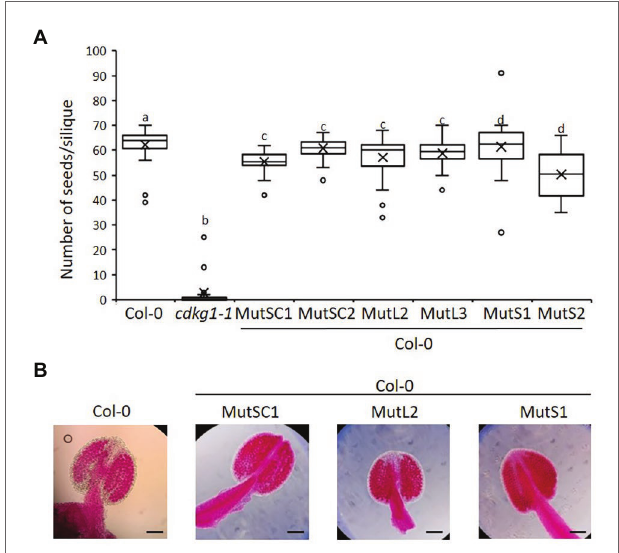
FIGURE 7 | The mutated kinase forms of CDKG1 do not act was dominant negative kinases in a Col-0 background. (A) Fertility counts of the kinase mutant transformed plants. The average number of seeds per silique was determined for Col-0, cdkg1-1 , and lines expressing the various constructs under the control of the CDKG1 promoter in a Col-0 background as indicated. Data represent average and the interquartile range for 30 siliques from three plants. Superscript letters represent significance groups for p < 0.001. (B) Pollen viability staining of the lines above. Round carmine- colored pollen grains are viable, while white/blue shrunken pollen is not viable. Scale bar = 100 μ